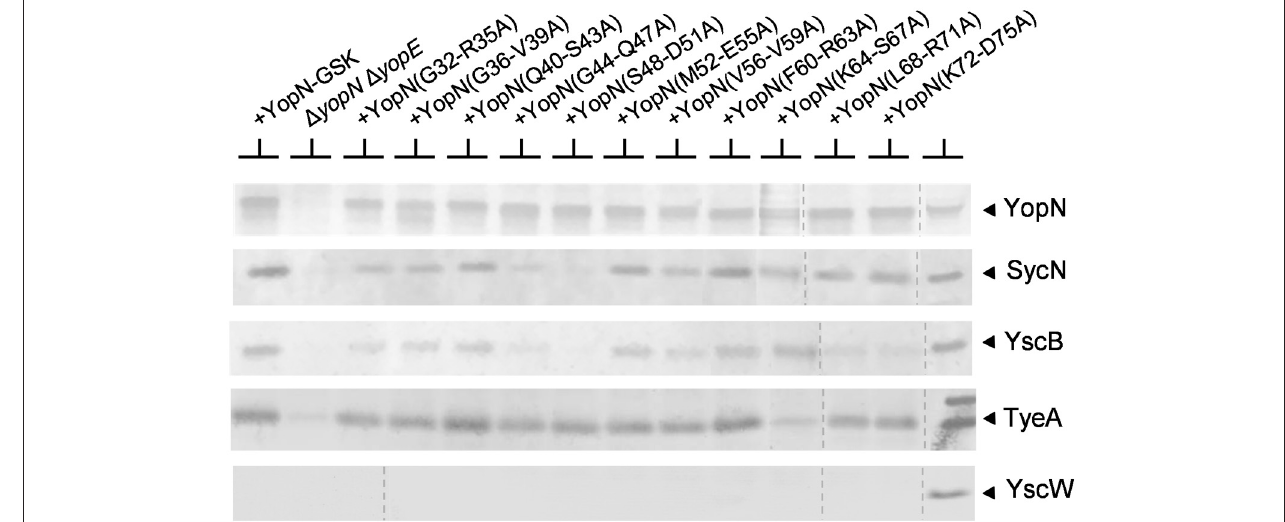
FIGURE 4 | Interaction of the SycN/YscB chaperone and TyeA with YopN and the YopN tetra-alanine substitution mutants. The interaction of YopN with the SycN/YscB chaperone was analyzed via immunoprecipitation of YopN and co-immunoprecipitation of SycN and YscB. Soluble lysates of Y. pestis KIM8.P39 (parent), KIM8.P62 ( (cid:2) yopN (cid:2) yopE ), and KIM8.P62 expressing YopN-GSK or one of the 11 YopN-GSK tetra-alanine substitution mutants grown at 37 ◦ C in the absence of calcium were cross-linked with DSP (1mM), a thio-cleavable amine-specific